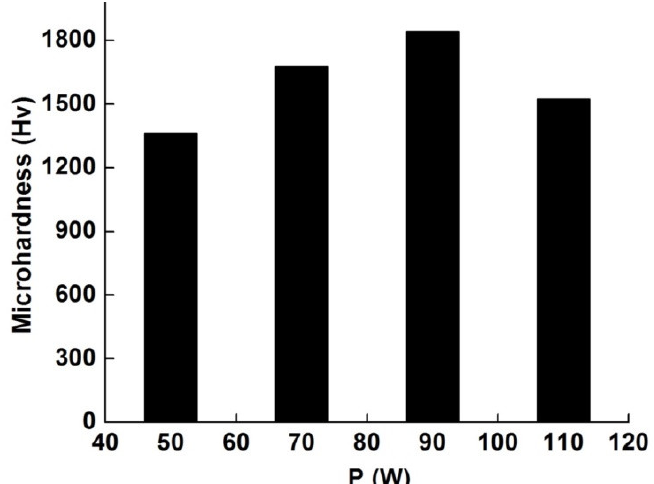
Figure 11. Variation of the microhardness as a function of laser